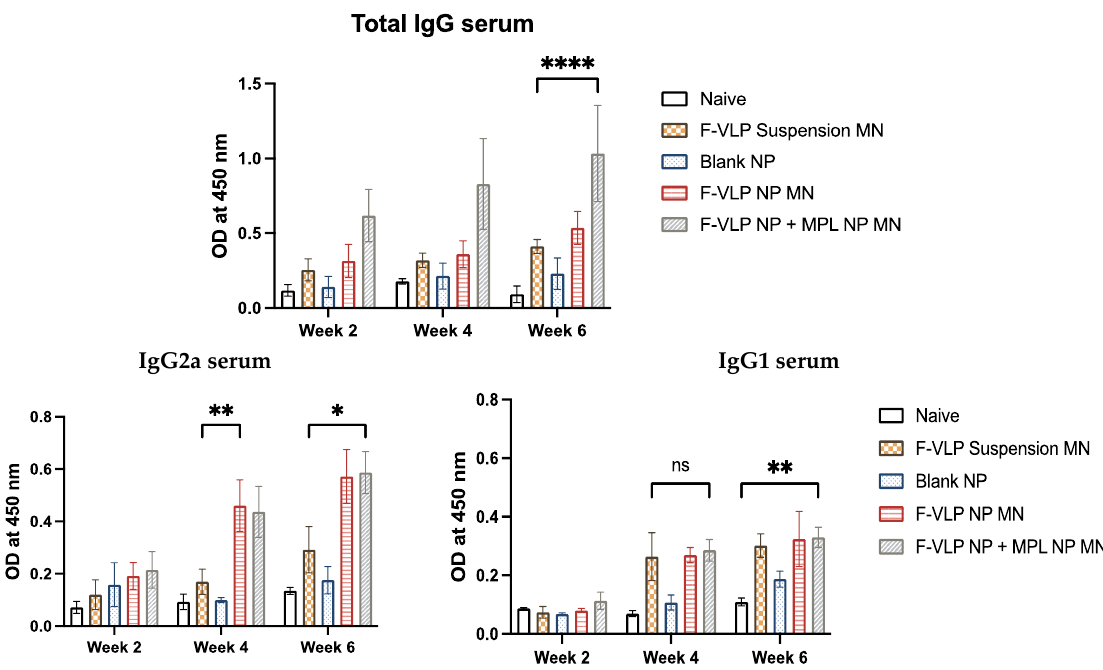
Figure 4. F-protein-specific antibody response in the serum of mice during and after immunization with nanoparticle-loaded microneedles. Serum antibodies specific to the RSV F-protein were ana- lyzed using the RSV F-protein as the ELISA-coating antigen. (Top) F-protein-specific IgG in the se- rum. (Bottom) F-protein-specific IgG subtypes, IgG2a, and IgG1 in the serum. * p < 0.05, ** p < 0.01,*** p < 0.001 and **** p < 0.0001 .